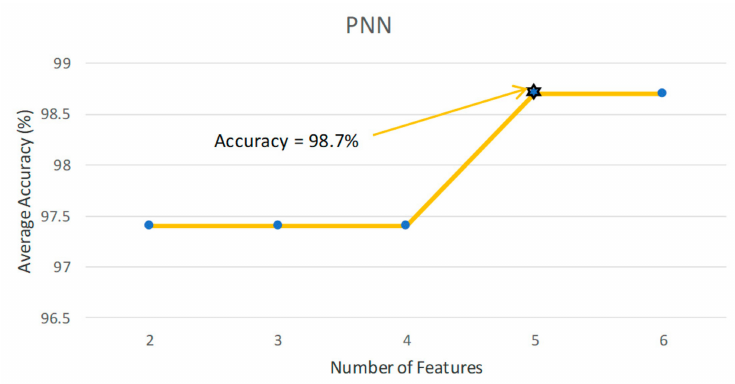
Figure 2. Classification accuracy versus number of features plot for the PNN model.